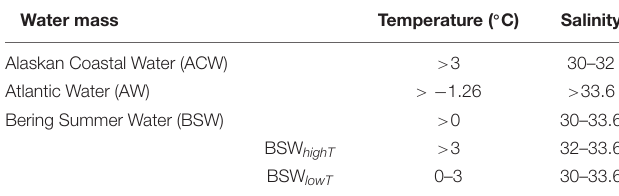
TABLE 1 | Summary of southern Chukchi Sea water mass characteristics. Water